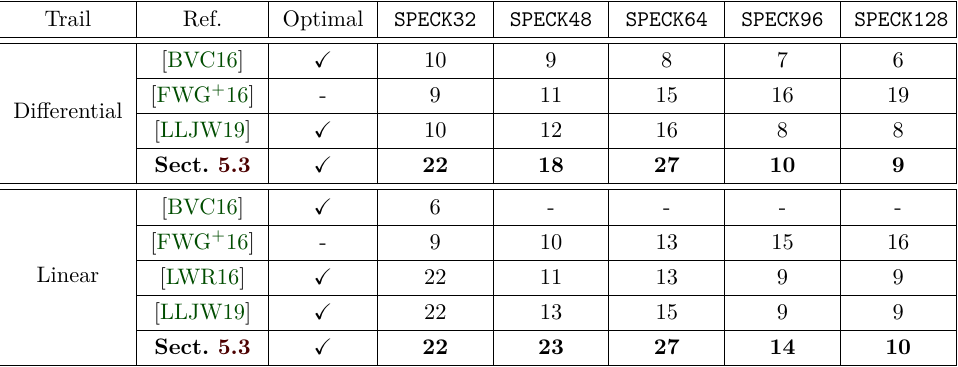
Table 1: The maximum length of trails with different approaches for SPECK .